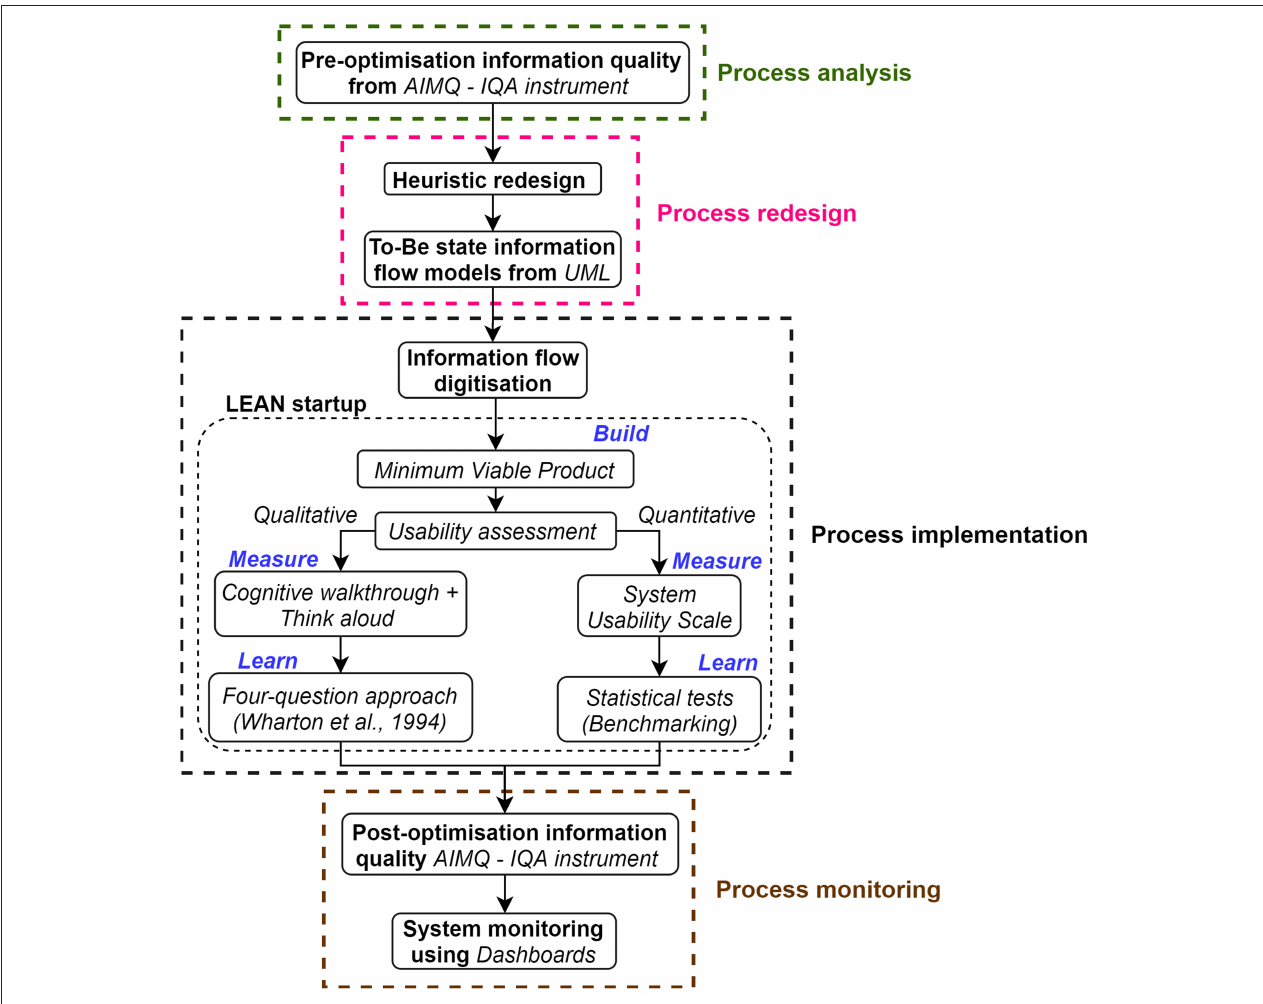
FIGURE 3 | The methods adopted to optimize the strength and conditioning information flow in the